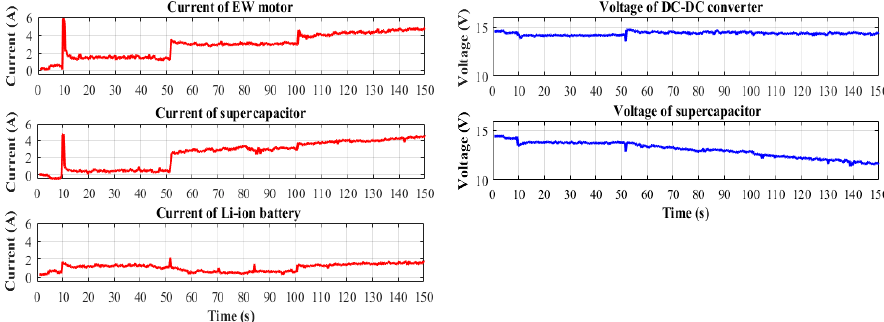
Figure 9. Experimental results of the SEMS on the electric wheelchair (EW) motor.